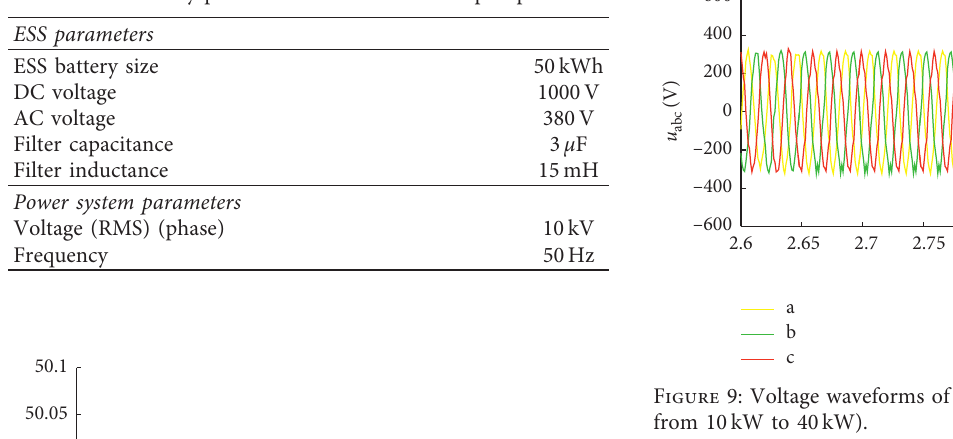
Table 1: Key parameters of ESSs and heat pumps.